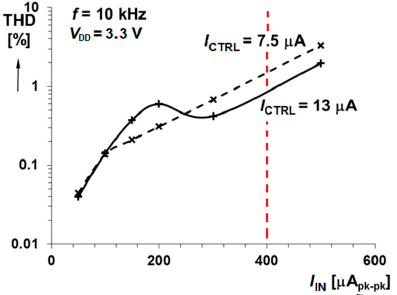
Figure 11. Measurement of output signal THD dependence on the input signal amplitude for two